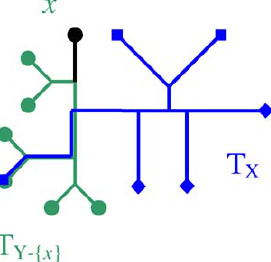
Figure 2. Representative Example for the Scenario Described in the Proof of Theorem 1. T X is depicted in blue and T Y- f x g in green. Species (leaves) in Y are represented by filled circles. DOI: